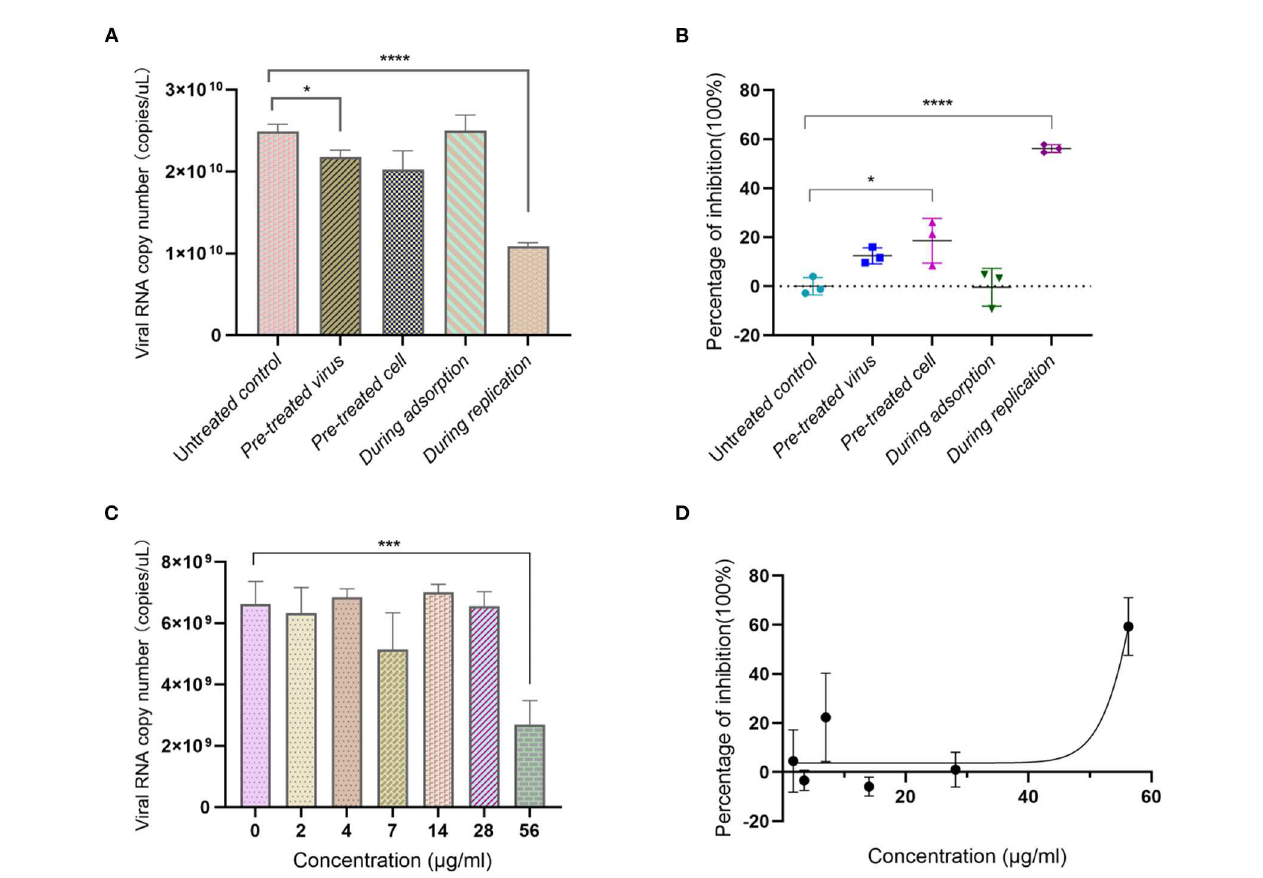
FIGURE3 Anti-SARS-CoV-2 virus effect of Ren’s oligopeptide. (A) Virus copy number of SARS-CoV-2 after addition of Ren’s oligopeptides to the Vero-E6 cells at different virus infection stages. (B) Inhibition rate of SARS-CoV-2 virus after adding Ren’s oligopeptides to the Vero-E6 cells at different virus infection stages. (C) Inhibitory rate of Ren’s oligopeptides at different concentrations on SARS-CoV-2. (D) Ren’s oligopeptide anti-SARS-CoV-2 dose-dependent curve. ns, not significant ( p > 0.05); * p < 0.05, *** p < 0.001, and **** p < 0.0001 from the Student’s t -test. Error bars represent SD from three